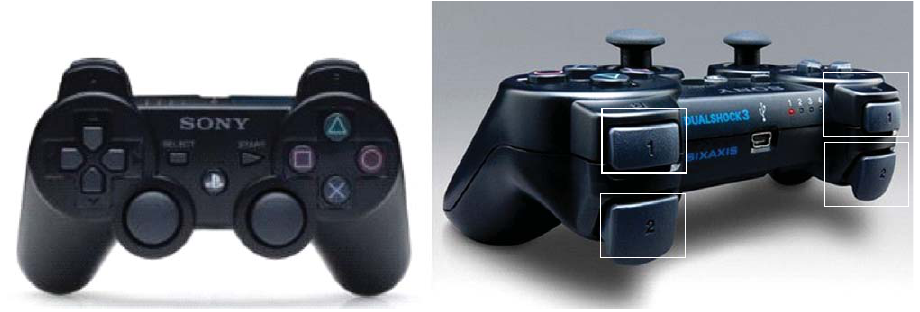
Fig. 2. PS3 ® Controller. When compared to previous controller, the PS3 ® Controller added a second pair of shoulder buttons for the middle finger in the basic button configuration. The squares indicate two pairs of shoulder